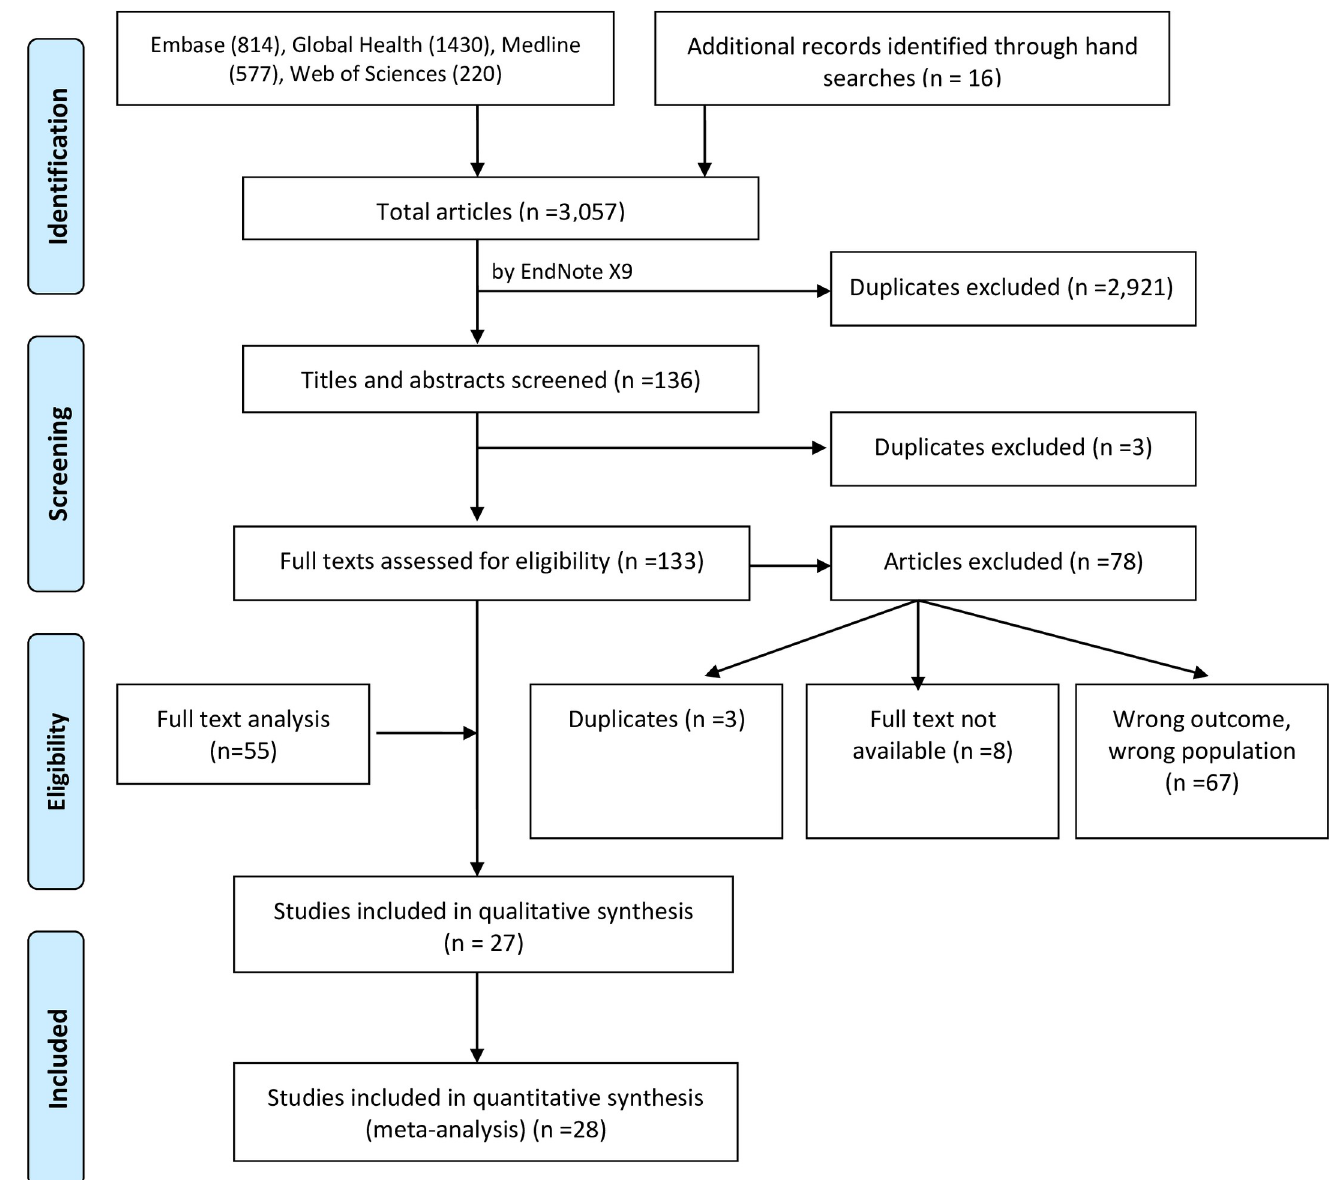
Fig 1. PRISMA flow diagram showing the process undertaken for inclusion and exclusion of studies in the systemic review. STH co-infection; 23 studied P . falciparum and S . haematobium co-infection; eight studied P . falciparum and S . mansoni co-infection and only two reported P . vivax and STH co-infection. Twenty-seven studies compared the odds of asymptomatic/uncomplicated or severe P . fal- ciparum infection and 16 studies compared P . falciparum density among children infected and uninfected with helminths. Fourteen studies compared the mean haemoglobin concentration or prevalence of anaemia among study participants who had Plasmodium and helminth infec- tions and those infected with Plasmodium infection only. Most of the studies reported asymp- tomatic and/or uncomplicated Plasmodium infection except three studies [43, 47, 54], which